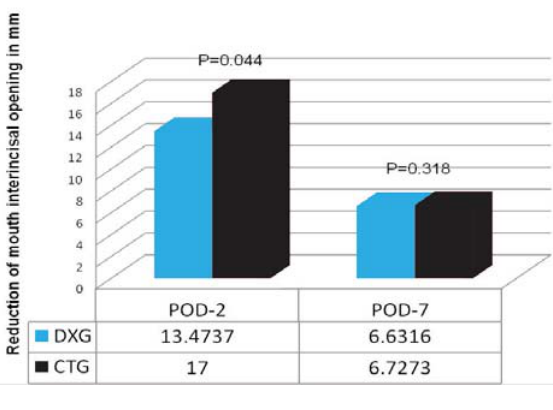
Figure 3. Effect of dexamethasone on post-operative trismus